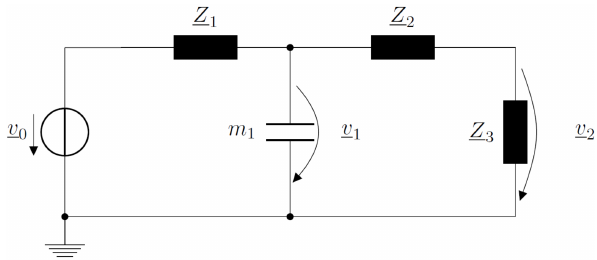
Figure 12. Simplified circuit model for Fig. 3 to derive analytical expressions for v 1 and v 2 in case of a given external interaction k 3 ,d 3 at the nanocantilever.